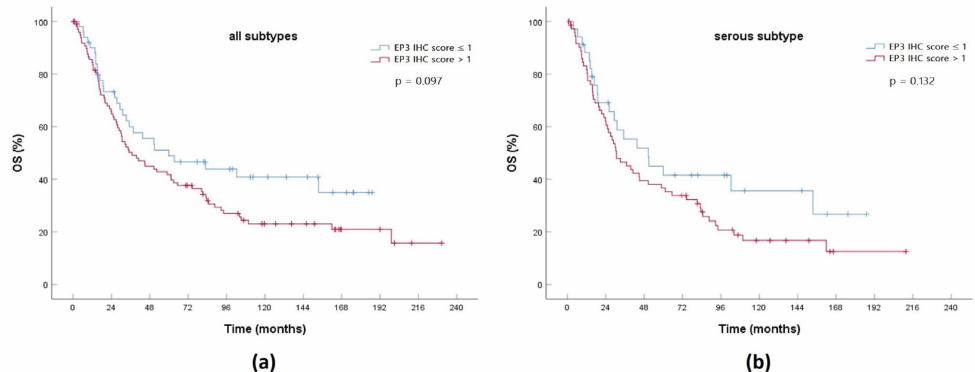
Figure 10. KM curve comparing OS between high prostaglandin E2 receptor 3 (EP3) expression (immunohistochemistry (IHC) score > 1) and low EP3 expression (IHC score ≤ 1) in an EOC cohort for: ( a ) all histological subtypes ( n = 151); ( b ) serous subtype ( n = 108).